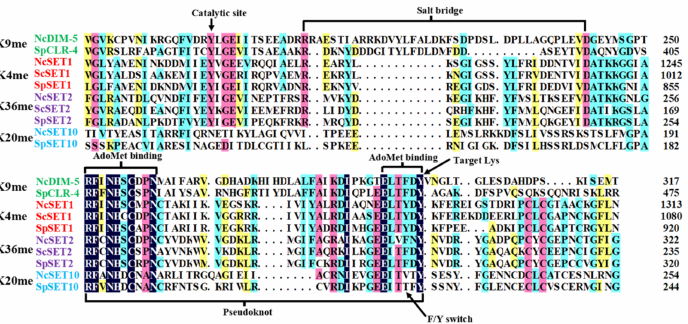
Figure 3. Alignment of several representative SET-domain-containing histone lysine methyltrans- ferases (HKMT) grouped according to their histone-lysine specificity from N. crassa (Nc), S. cerevisiae (Sc), and S. pombe (Sp). Those HKMTs all belong to Cluster 1 in Figure 2 with NcDIM-5 and SpCLR-4 belonging to Group 5, NcSET1, ScSET1, and SpSET1 belonging to Group 4, NcSET2, ScSET2, and SpSET2 belonging to Group 6, and NcSET10 and SpSET1 belonging to Group 12. The residues of the AdoMet, target lysine, catalytic site, the structural pseudoknot, an intra-molecular interacting salt bridge, and a F/Y switch controlling whether the product is a mono-, di- or tri-methylated histone are indicated.